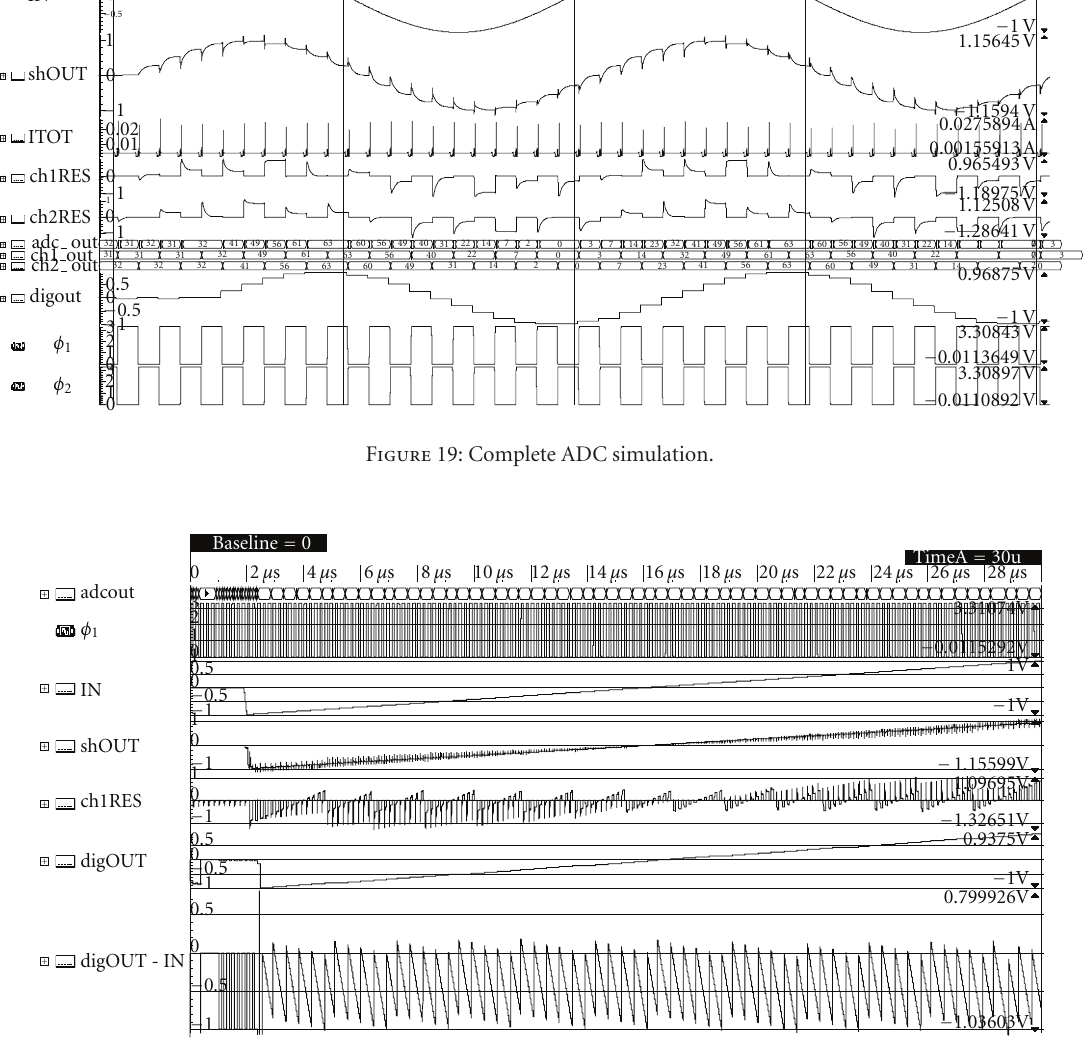
Figure 20: ADC linearity